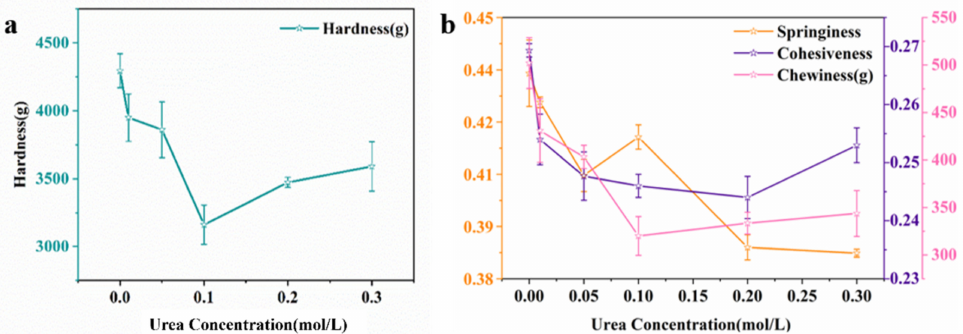
Figure 3. Textural profile analysis (TPA) parameters of hardness of composite hydrogel with different urea concentrations ( a ); springiness, cohesiveness and chewiness of composite hydrogel with different urea concentrations ( b